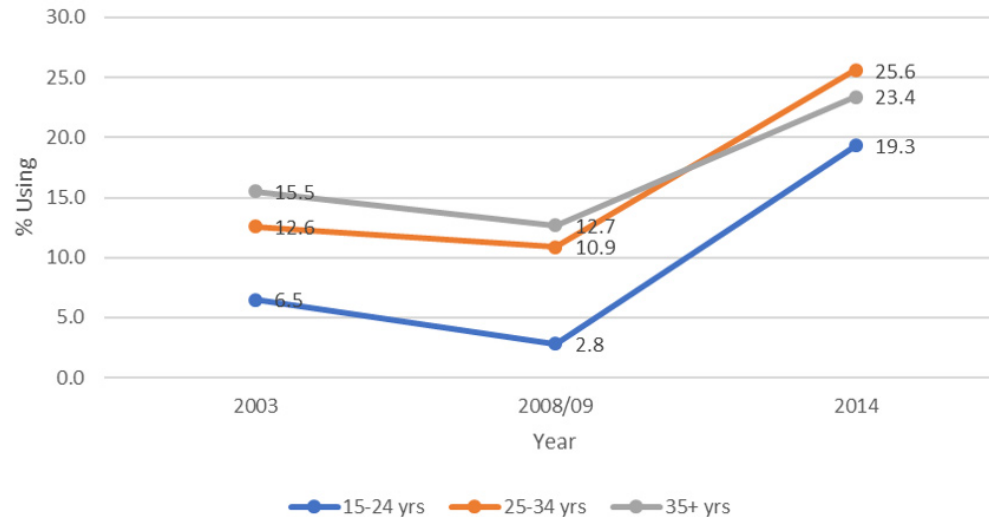
Figure 1. Long-acting reversible contraception use by age in Kenya, 2003–2014.